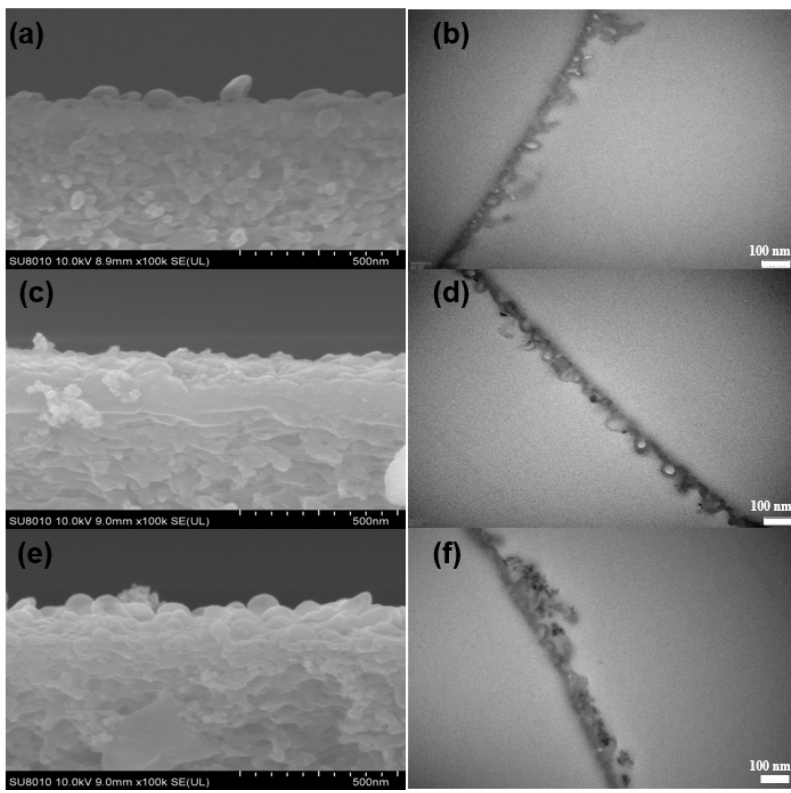
Figure 5. SEM ( left ) and TEM ( right ) images of cross-sections of membranes with different concentrations of R812S NPs: ( a , b ) no NPs, ( c , d ) 0.02% ( w / v ) and ( e , f ) 0.1% ( w / v ).